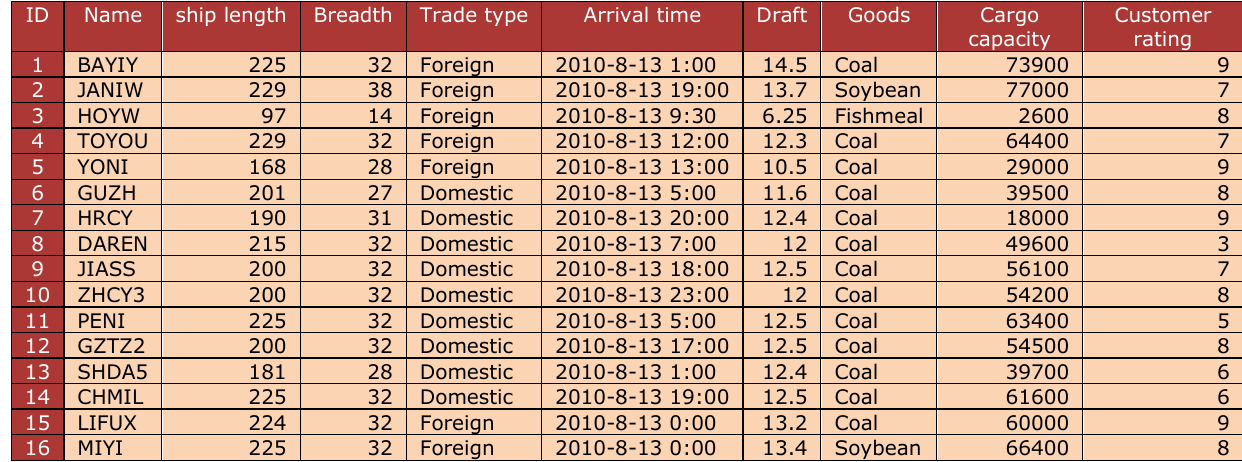
Table 6. Ship data